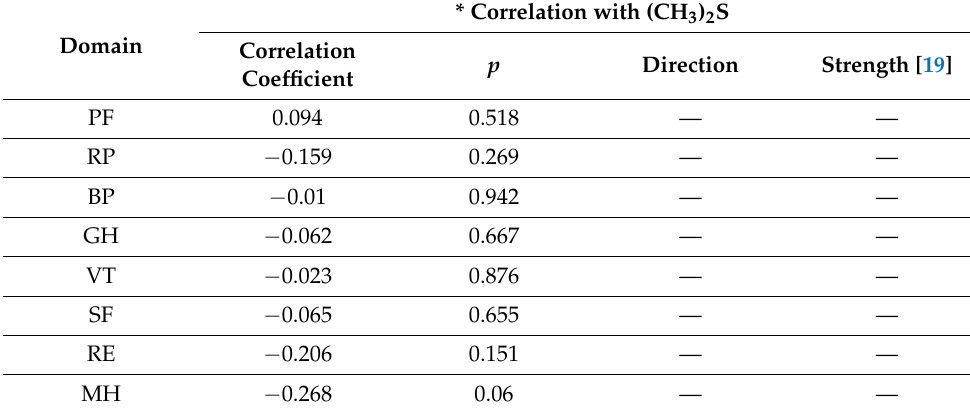
Table 5. SF-36 domains’ and (CH 3 ) 2 S correlation.